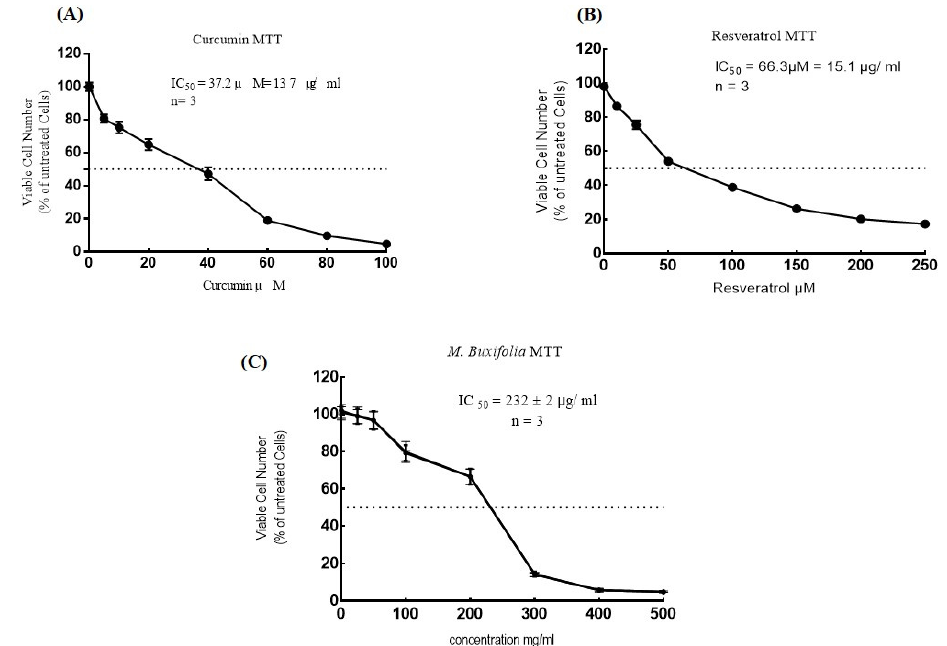
Figure 1. Analysis of percentage of MCF-7 cell death by MTT assay at different doses of ( A ) Curcumin, ( B ) Resveratrol, and ( C ) MMBL after 48 h of incubation. Each value represents a mean ± SD ( n = 3). MMBL: methanolic extract of M. buxifolia leaves; MTT: (3-(4,5-dimethylthazolk-2-yl)-2,5-diphenyl tetrazolium bromide) assay; APT: acid phosphatase assay. Table 2. Cytotoxicity analysis of MMBL along with standard natural